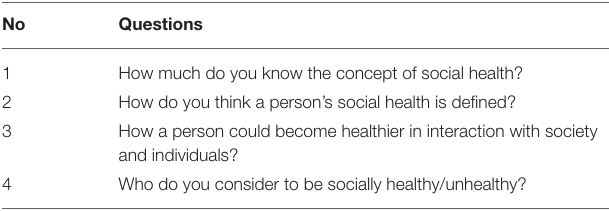
TABLE 1 | Checklist for questions of the interview guide. TABLE 2 | Demographic characteristics of adults’ participants in the